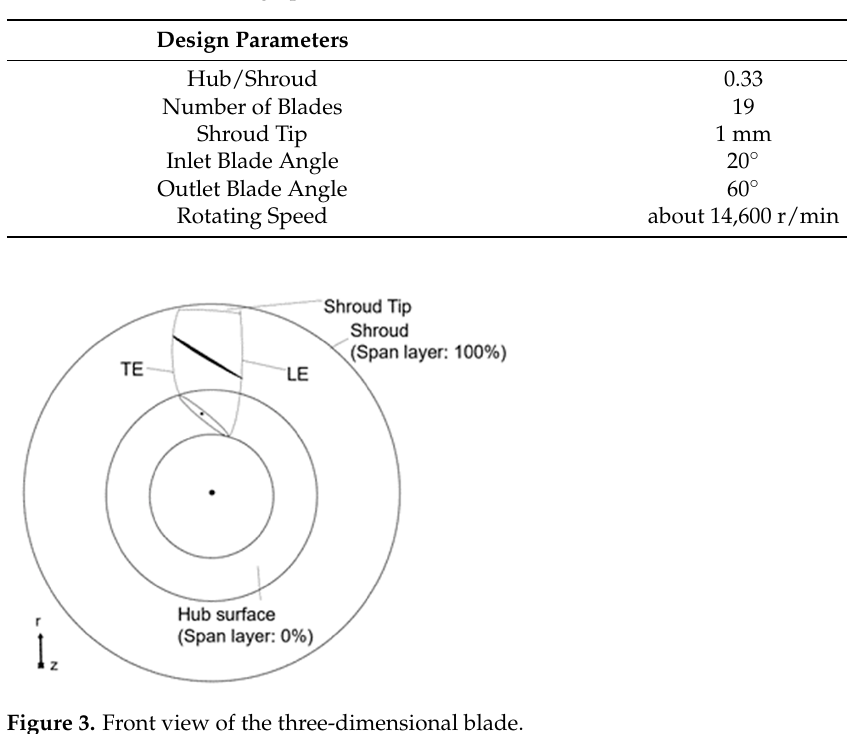
Table 2. Geometrical design parameters of the initial rotor.